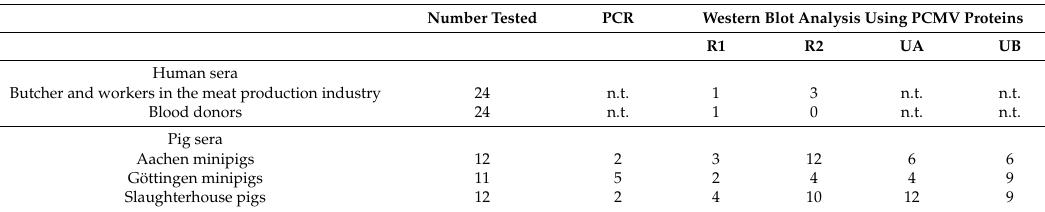
Table 1. Testing of pig and human sera for PCMV by Western blot analysis, in parallel PCMV infection was determined by PCR. n.t., not tested.